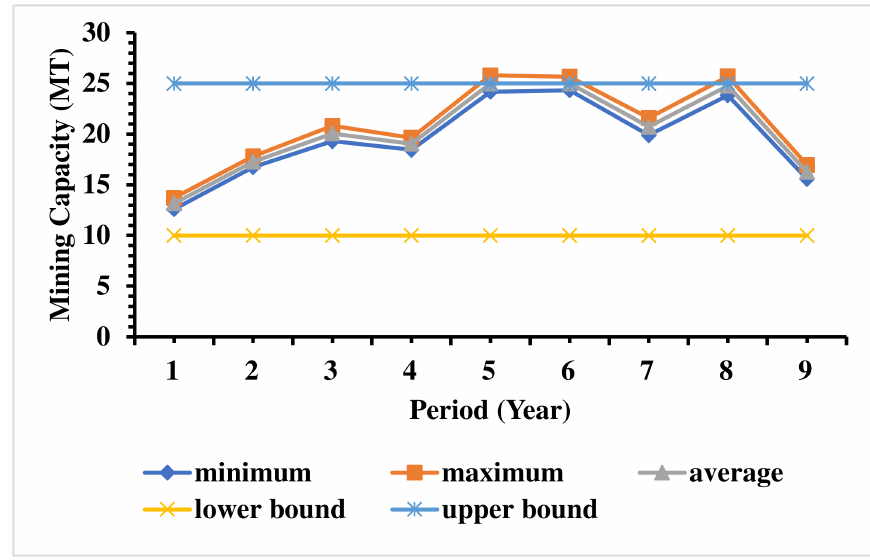
Figure 2. Raw material production from the study mine using the proposed approach.